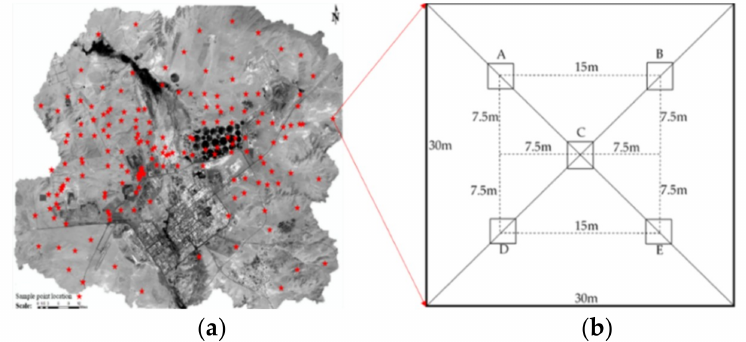
Figure 3. Spatial distribution of sample plots and Layout of the quadrat. ( a ) Spatial distribution of sample plots; ( b ) Layout of the